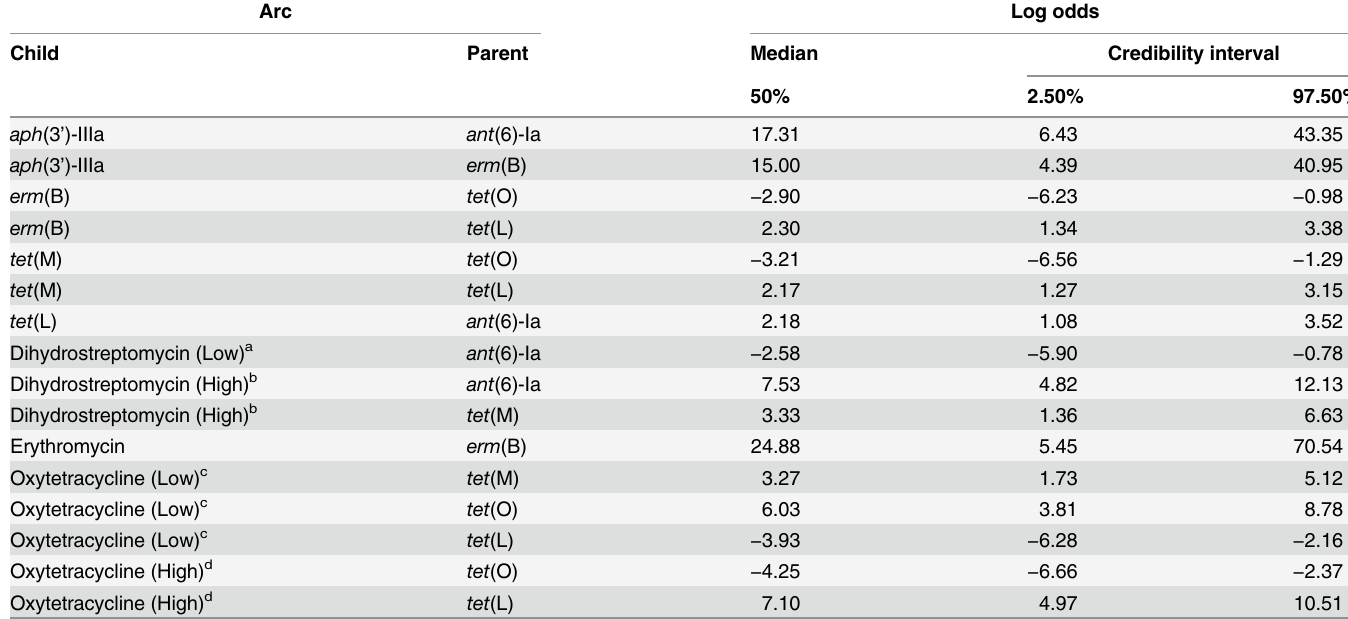
Posterior estimates for remaining arcs obtained from the fi nal ABN model after bootstrapping. The median and 95% credibility intervals for each